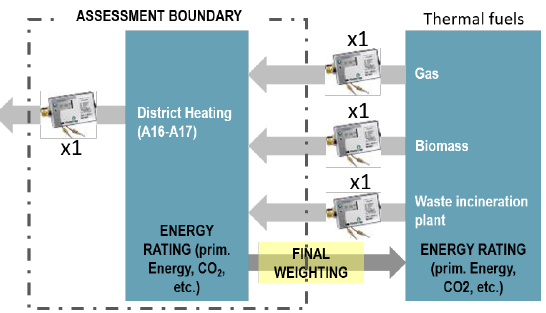
Figure 4. Monitoring programme for district heating in